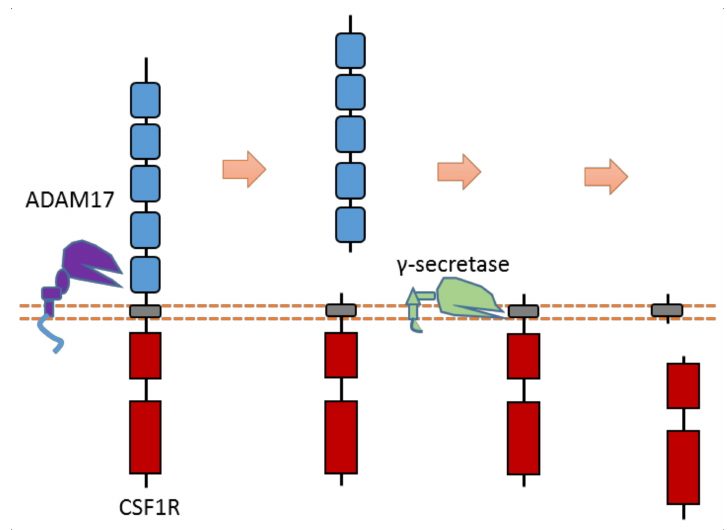
Figure 16. Schematic illustration of proteolytic cleavage in